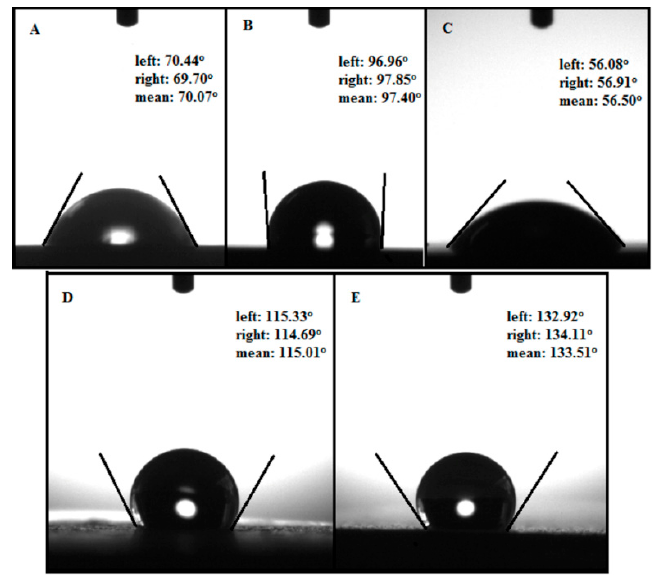
Figure 7. Contact angle (CA) for: ( A ) native material after grinding (MR), ( B ) native material after etching (MRe), ( C ) carbon nanotube coating on the surface of Ti13Nb13Zr (0.27CNT), ( D ) carbon nanotube coating on the surface of the hydroxyapatite (H0.27CNT), ( E ) the mixed coating consisting of carbon nanotubes, nanohydroxyapatite, nanosilver and nanocopper (m0.4CNT).